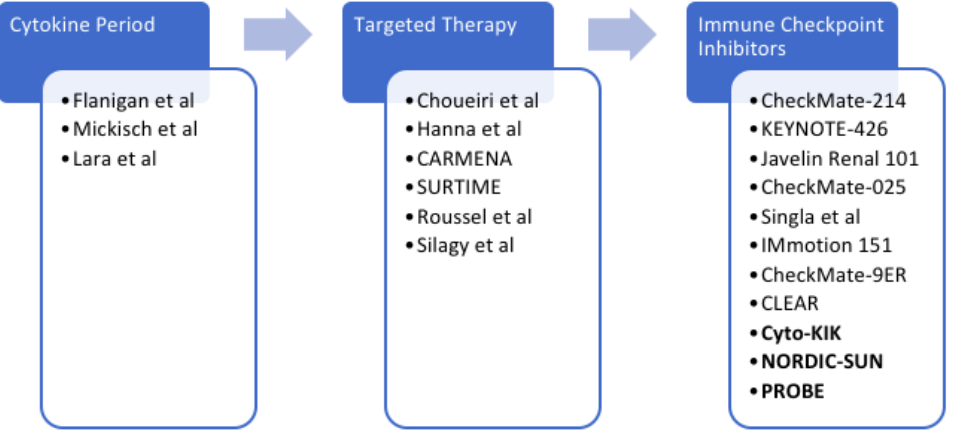
Figure 1. Depiction of the different eras of systemic therapy and the landmark papers evaluating the role of CN during these periods [10,11,13 – 15,17,18,21,22,25,28]